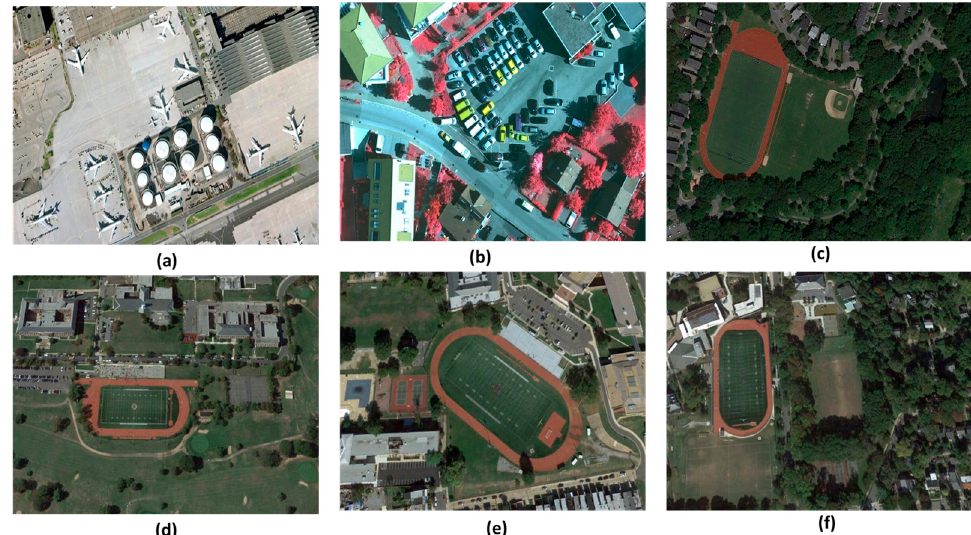
Figure 1. Examples in the NWPH VHR-10 dataset. ( a ) storage tanks and airplanes ( b ) vehicles ( c ) ground track field and baseball diamond. ( d – f ) ground track fields under different flight heights and shooting angles.